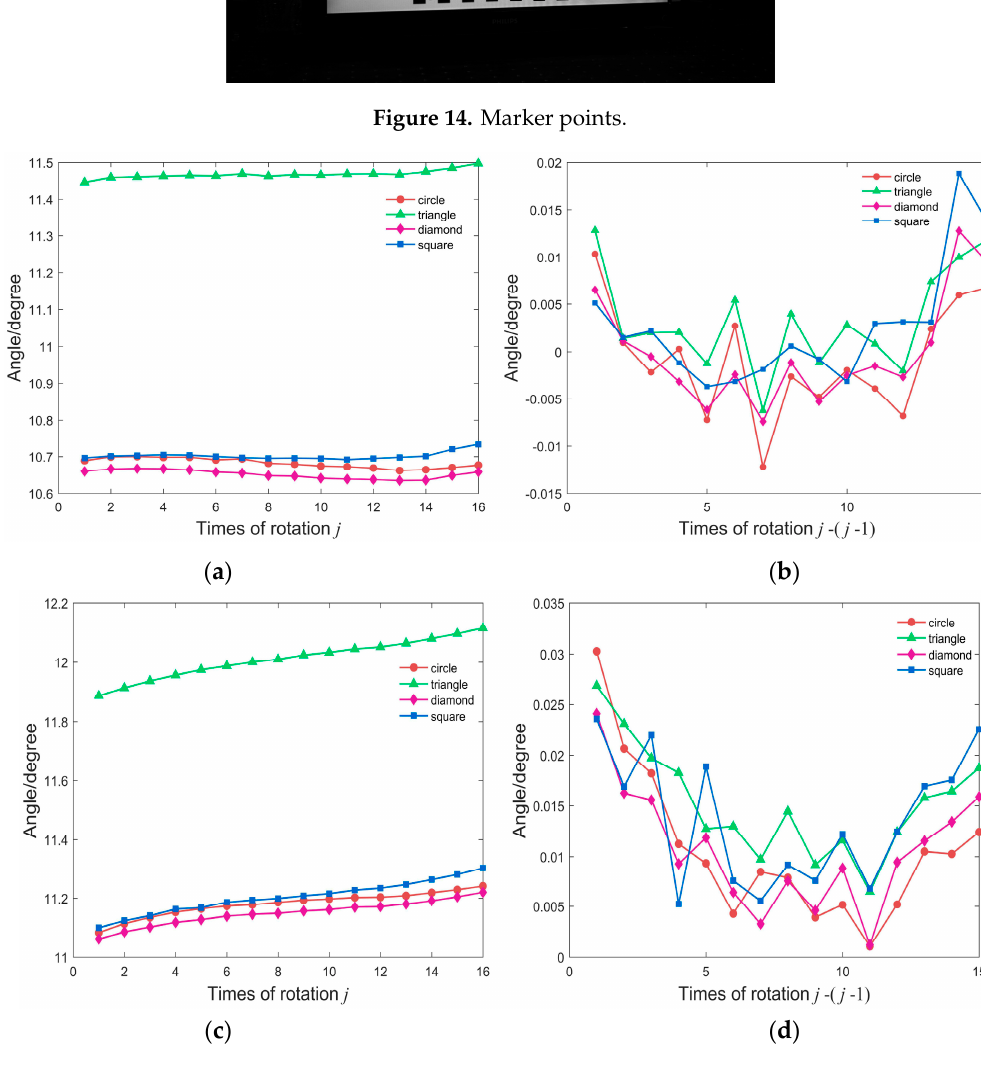
Figure 15. ( a ) The angle curves when coaxial; ( b ) the difference curves of the adjacent angles when coaxial; ( c ) the angle curves when off-axis; ( d ) the difference curves of the adjacent angles when off-axis. Table 5. The standard deviation of the angles of the four sets of marker points.